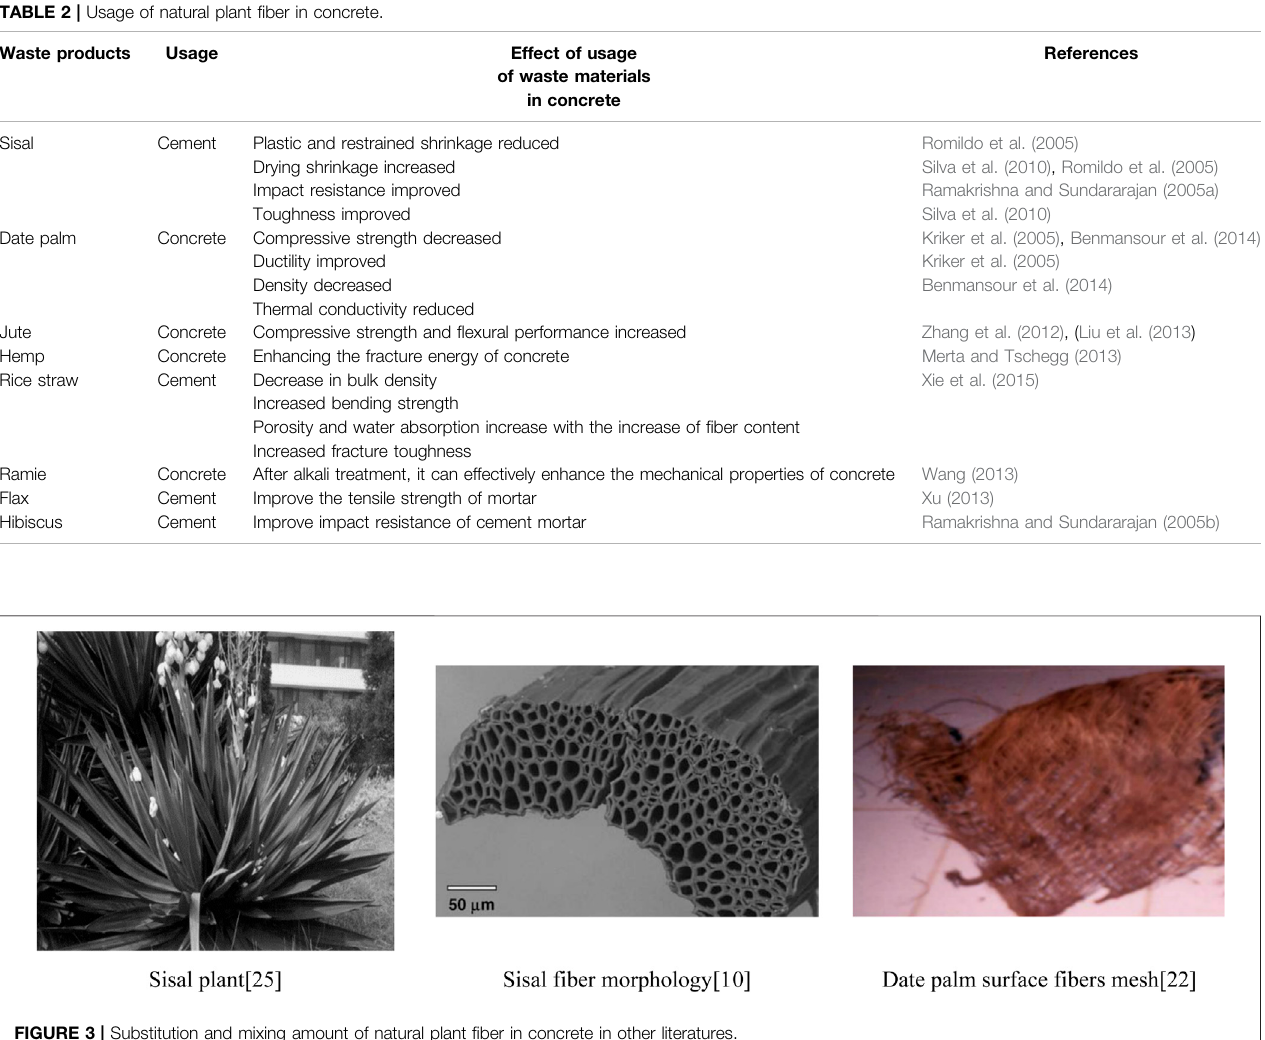
Frontiers in Materials |